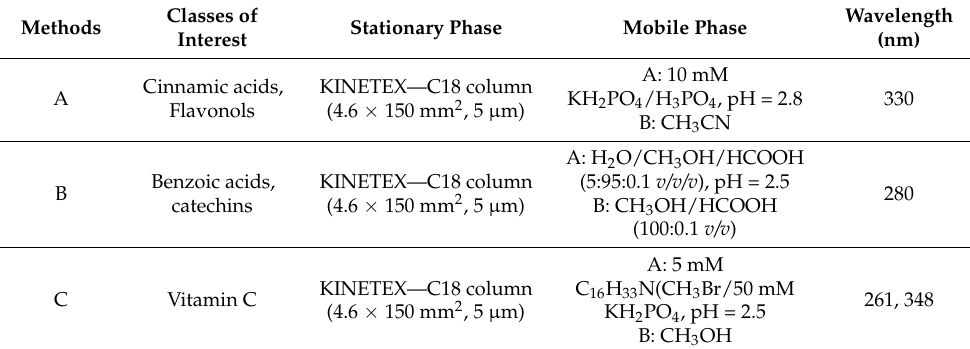
Table 5. HPLC methods and